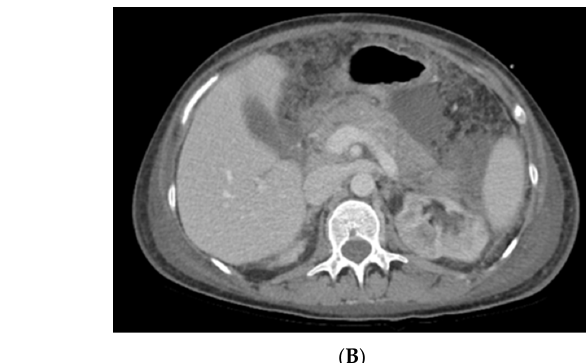
Figure 2. Thoracic CT scan. ( A ) Native thoracic scan showing bilateral COVID-19 pneumonia, af- fecting 30% of the lungs, and minimal right pleural effusion. ( B ) Contrast-enhanced thoracic CT scan revealing medium right pleural effusion and bilateral COVID-19 pneumonia. ( C , D ) Native thoracic CT scan, transversal view with bilateral pleural effusions and bacterial pneumonia. ( E , F ) Native thoracic CT scan, sagittal view with large right pleural effusion, inferior right lobe atelectasis, and bacterial pneumonia.